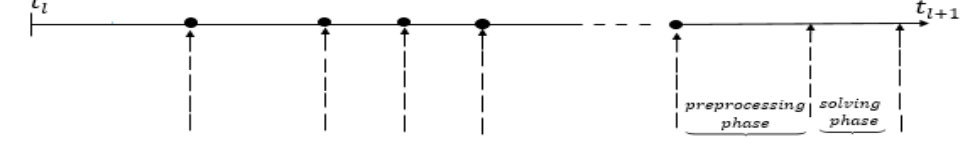
Figure 6. Proposed strategies for DM-CVRP.